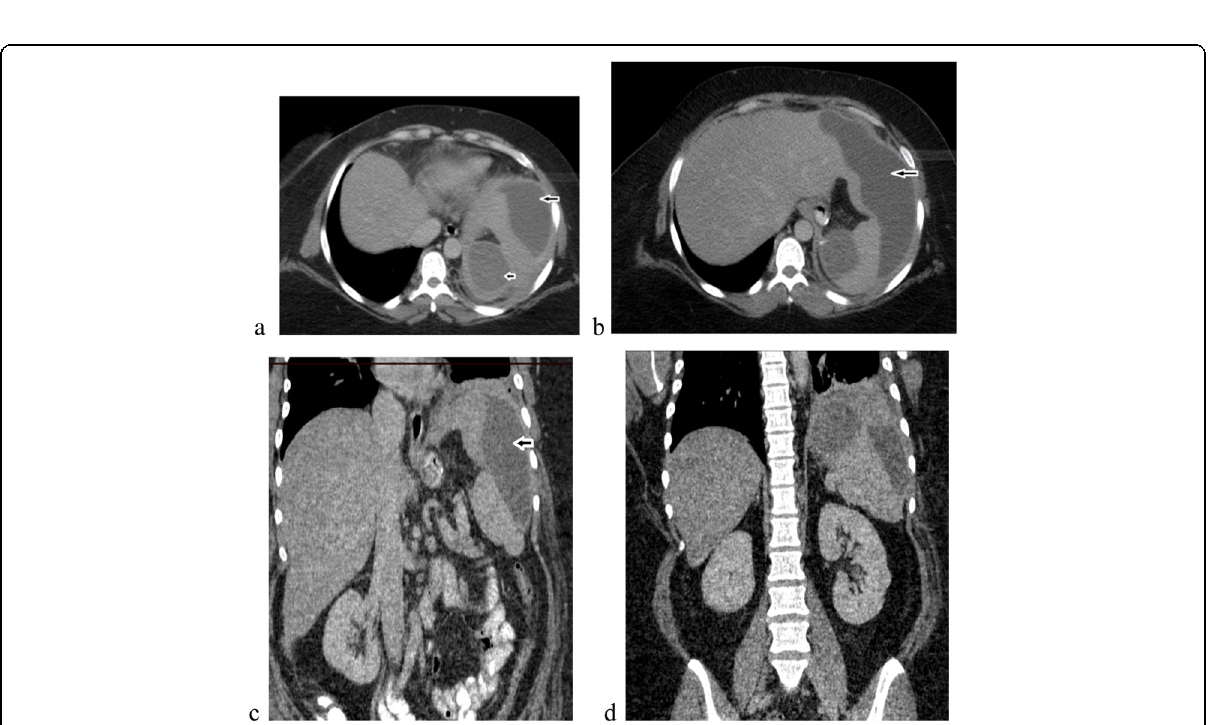
Fig. 14 A thirty-nine-year-old female patient with BMI of 48 kg/m 2 weighted 160 kg presented immediate post-lap. sleeve gastrectomy by severe abdominal pain and tachycardia. a , b MSCT axial and c , d coronal reformatted images showed an upper pole subcapsular hematoma and another encapsulated homogenous fluid adjacent to the lateral and superior aspect of the spleen extending superomedially to the left lobe of the liver anteriorly. UGSI shows no abnormality. MSCT diagnosis: upper pole subcapsular hematoma and another encapsulated subcapsular/perisplenic